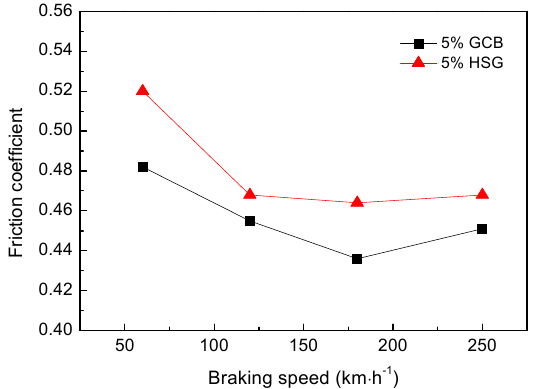
Figure 8. Effect of different lubricating phase on friction coefficient of materials.